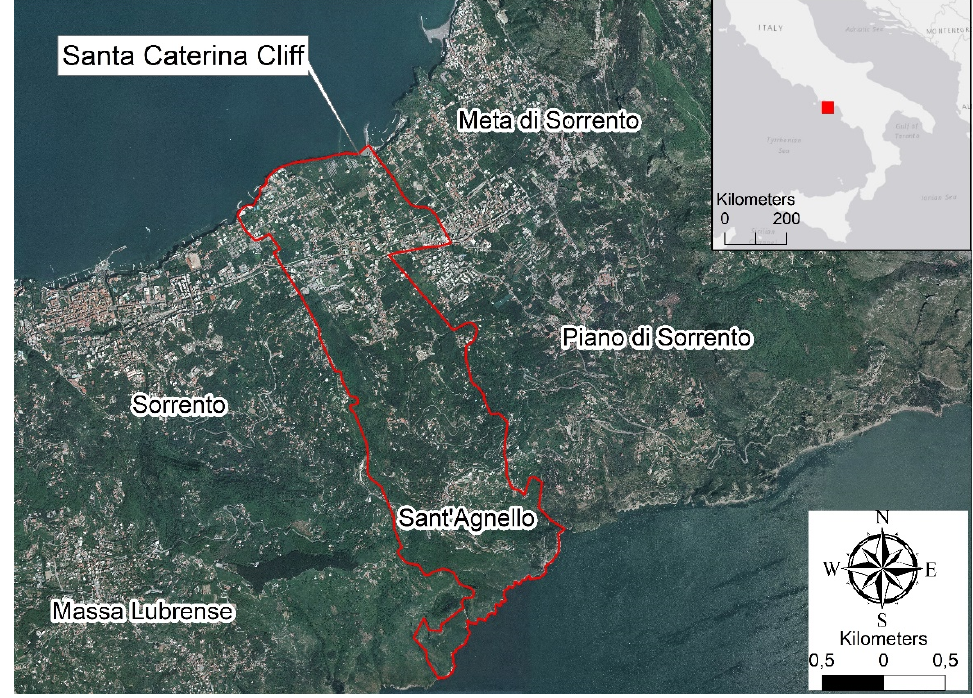
ff , in Campania, southern